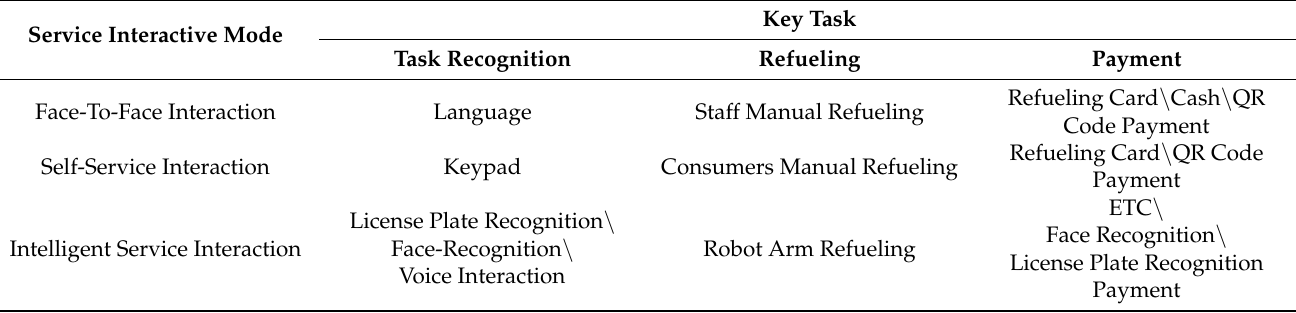
Table 1. These are tools for completing key tasks in different service interaction